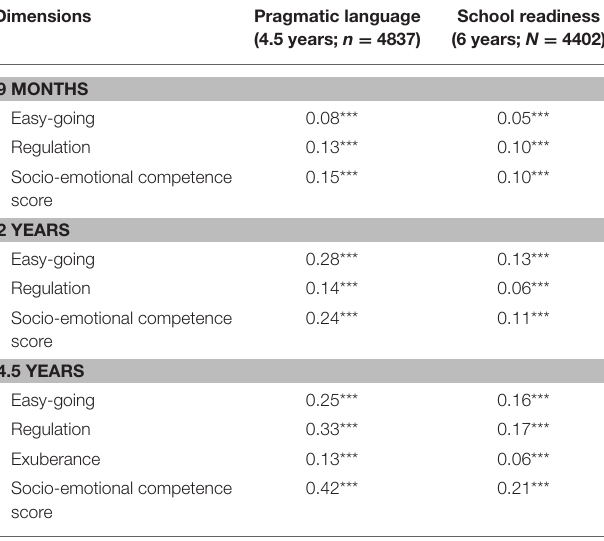
TABLE 5 | Pearson correlations between dimensions (Easy-going, Regulation and Exuberance) and overall scores of socio-emotional competence scores at each DCW with pragmatic language (4.5 years) and school readiness (6